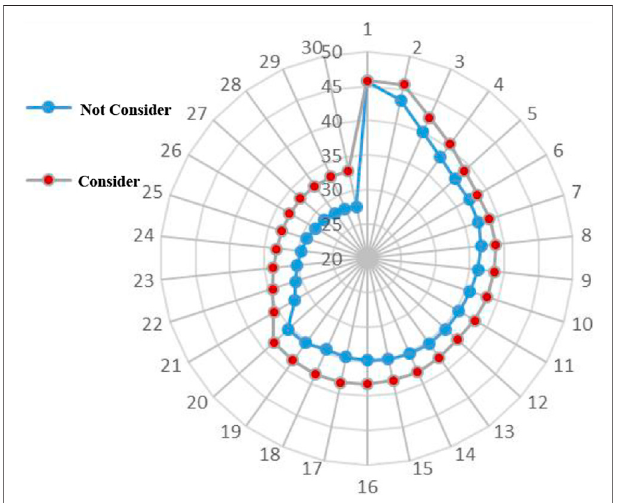
FIGURE 11 | Effect of stress sensitivity on bottom hole